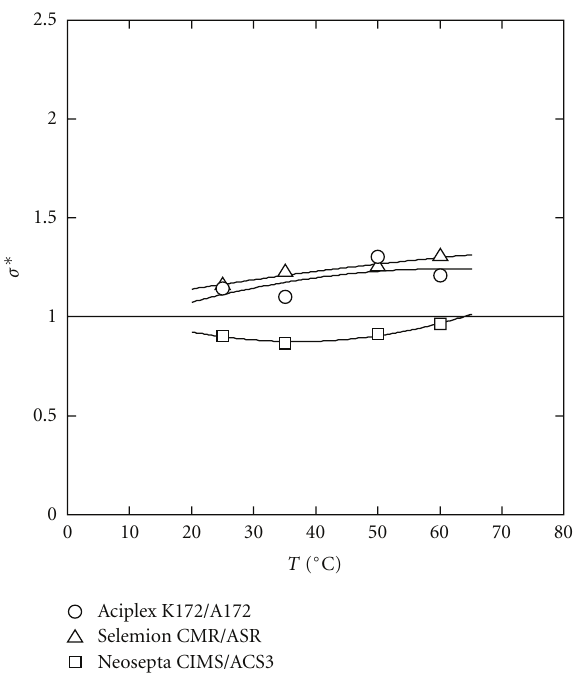
Figure 13: Relationship between temperature and overfull concen- tration reflection coe ffi cient.